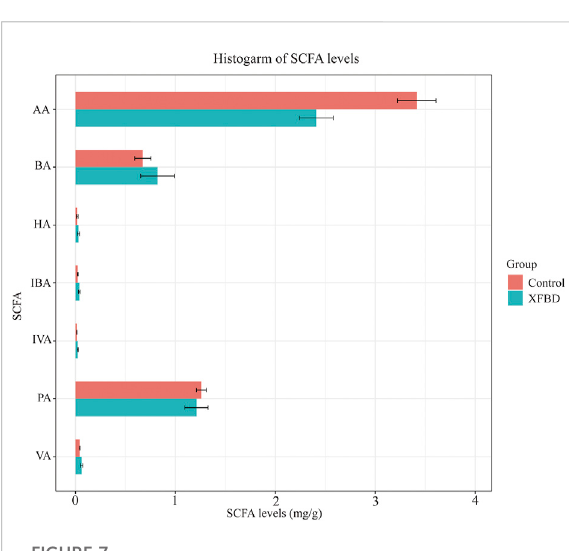
FIGURE 7 Diagrams of changes in expression levels of short-chain fatty acids. AA, Acetic acid; PA, Propionic acid; IBA, Isobutyric acid; BA, Butyric acid; IVA, Isovaleric acid; VA, Valeric acid; HA, Hexanoic